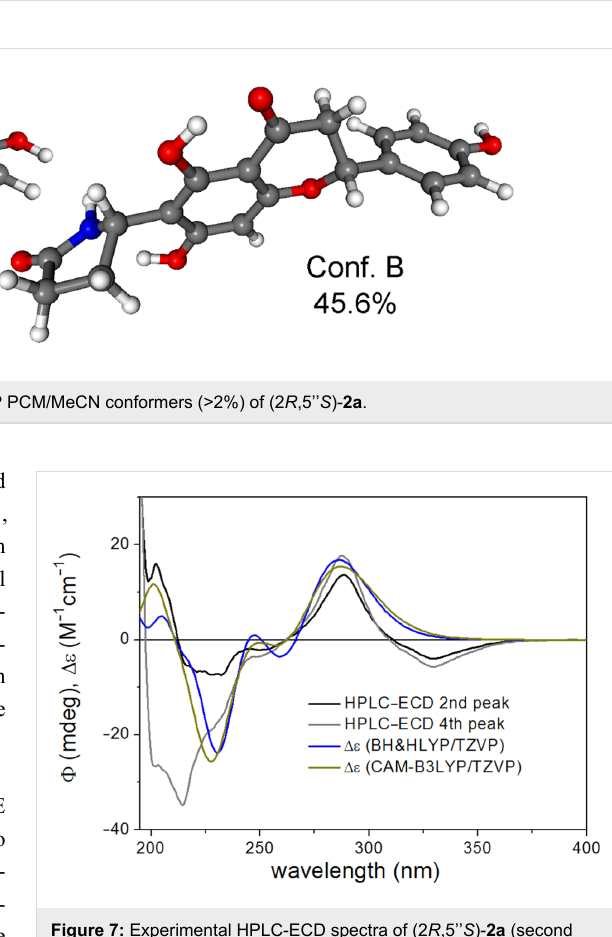
Figure 5: Structure and population of the low-energy CAM-B3LYP/TZVP PCM/MeCN conformers (>2%) of (2 R ,5’’ R )- 2d .